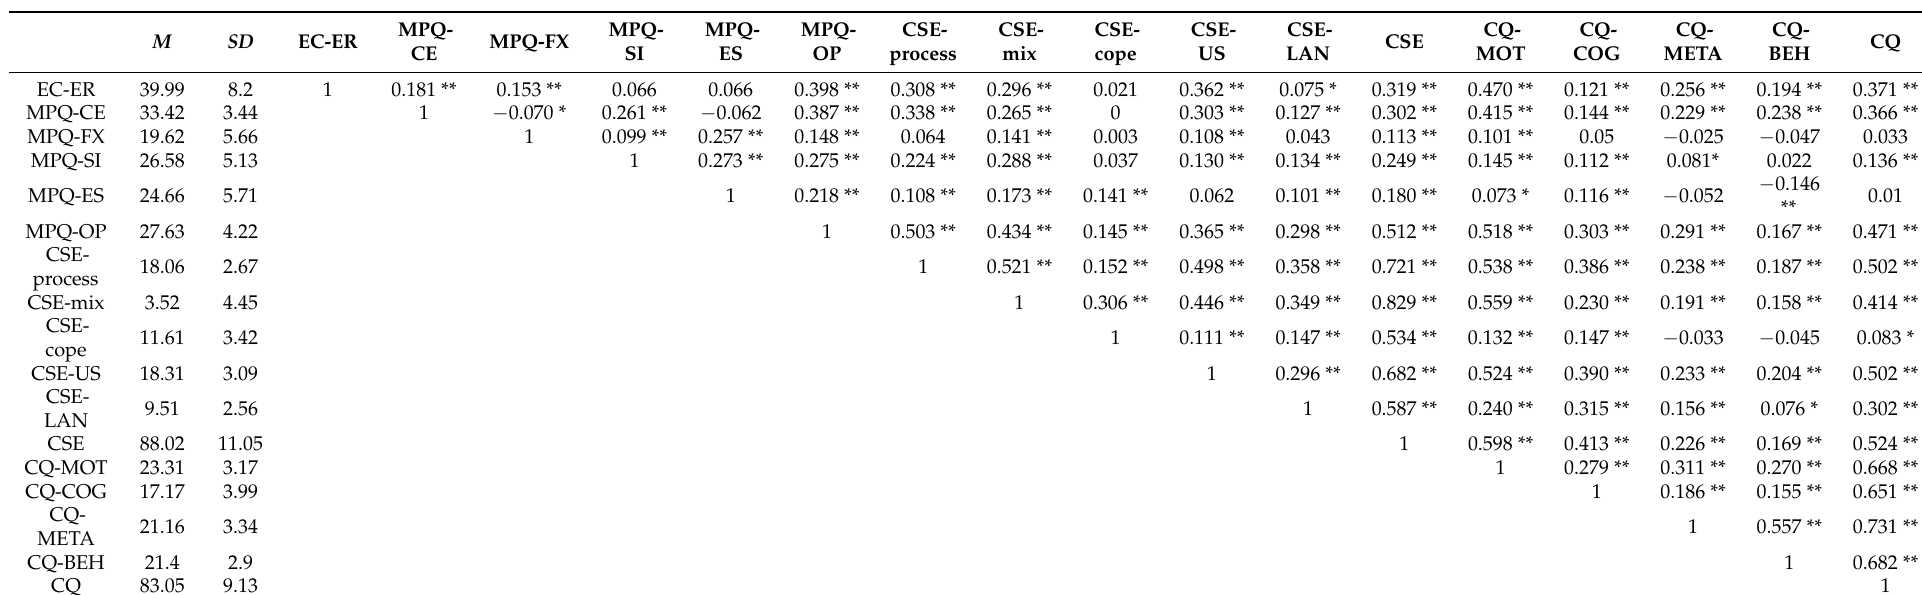
Table 1. Correlation